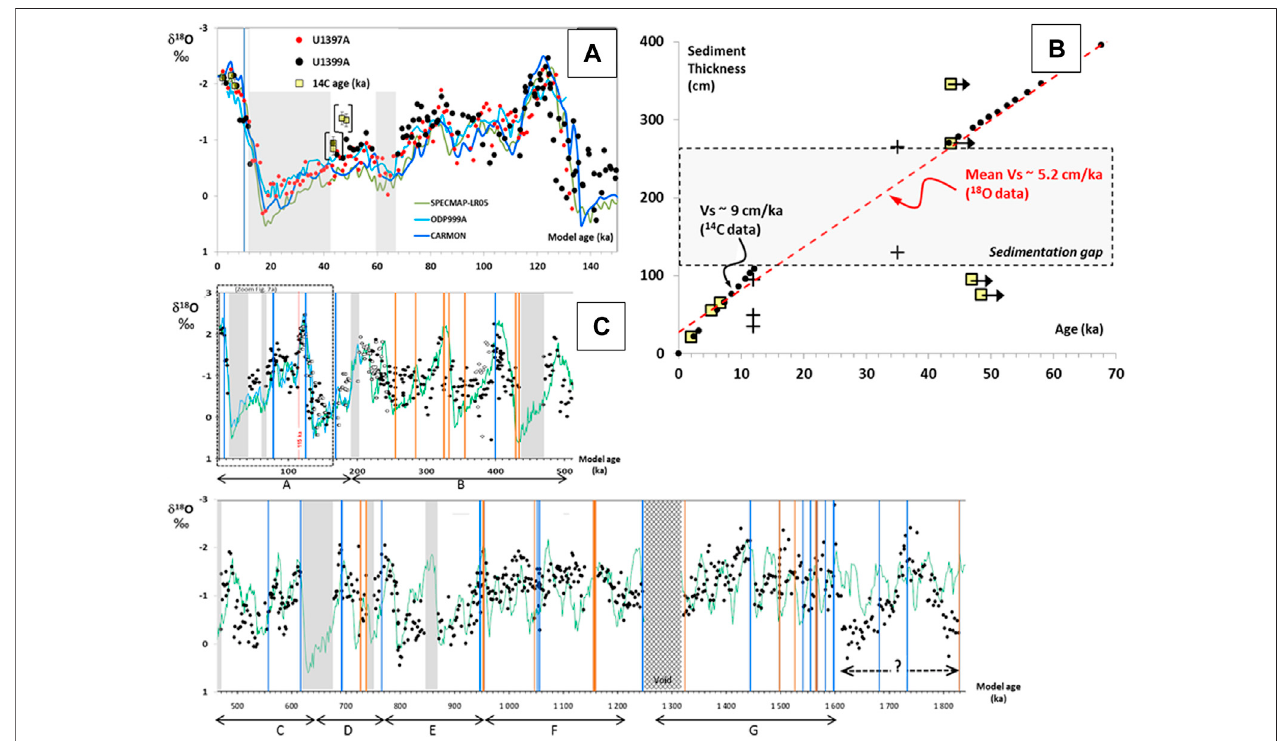
FIGURE7| Modelageandsedimentation rateofcoreU1399A. (A) Modelageforthetimeperiod 0 – 150 ka.Dots: δ 18 OdataofcoresU1399A(black)and U1397A (red). Squares: 14 C data of core U1399A; error bars are within symbol size; black arrows: data out of 14 C dating range. Continuous lines: standard δ 18 O — age patterns. Bluebars:turbidites > 50 cm;orangebars:debrites.Graydomain: erosionorsedimentationgaps(identi fi edbyarrowsin Figure6A ). (B) Sedimentationrate.Blackdots: U1399A; squares: 14 C data. V ° S : mean hemipelagic sedimentation rates. Crosses: data of cores En 6, GS 2 and GS 18 (biochronology, Reid et al., 1996; see